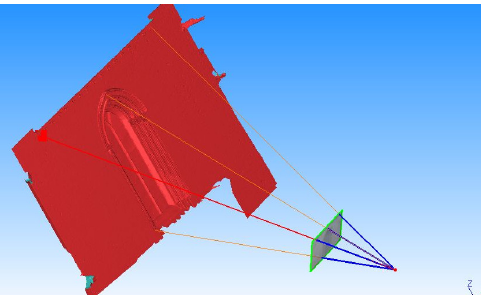
Figure 6: The projection of the image on part of the